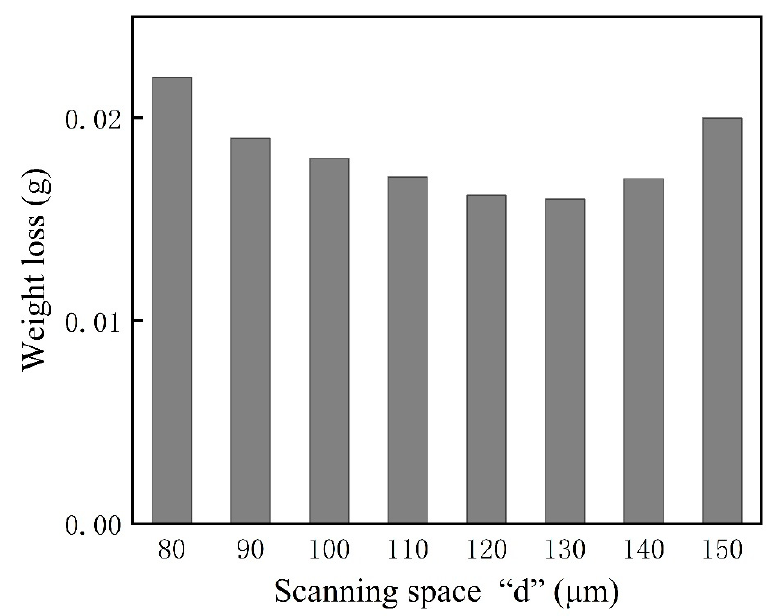
Figure 12. Weight loss with different scanning spaces.